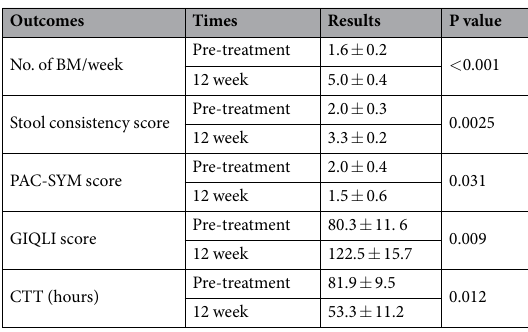
Table 2. Outcome measures in constipated patients with fecal microbiota transplantation (n = 6). BM, bowel movement; PAC-SYM, Patient Assessment of Constipation Symptoms; GIQLI, Gastrointestinal Quality-of-Life Index; CTT, colonic transit